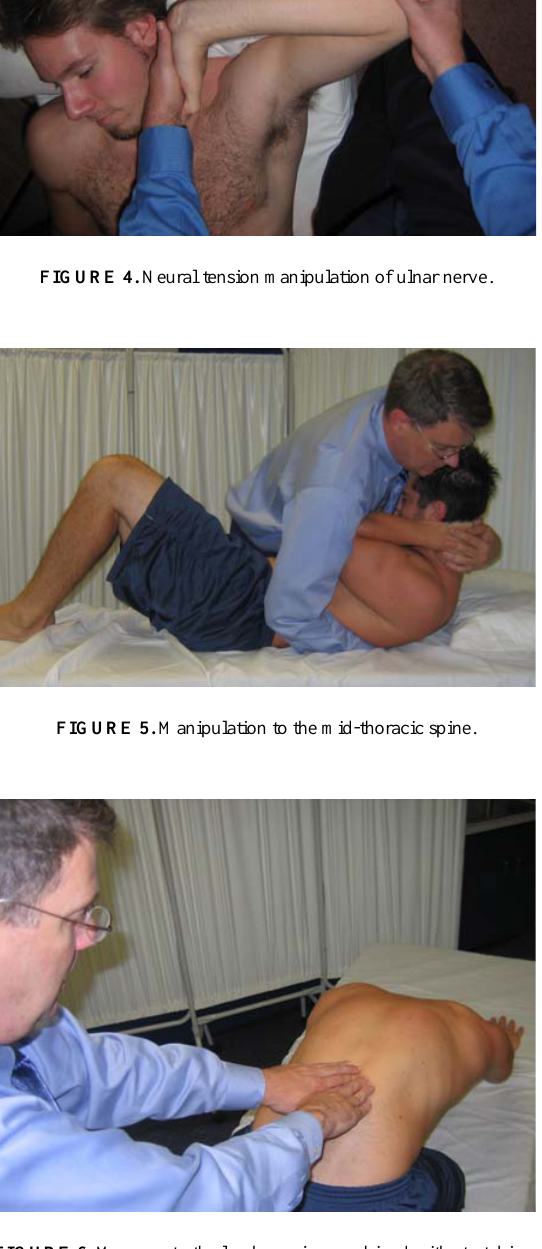
FIGURE 6. Massage to the lumbar spine combined with